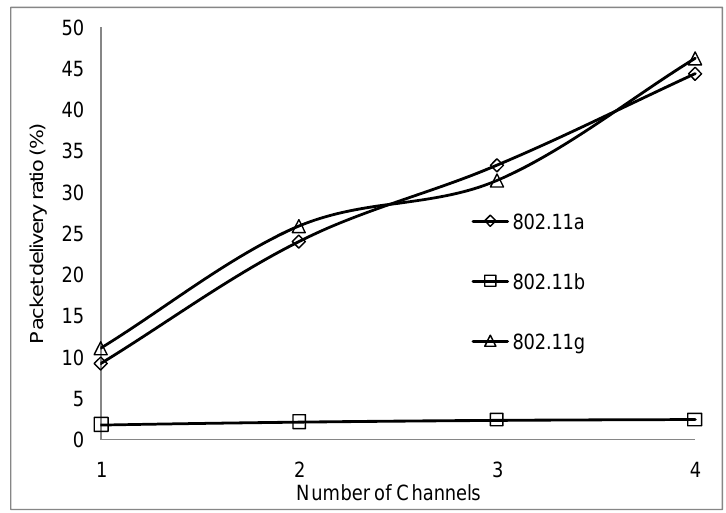
Figure 35. Delivery ratio at 100 m range and data rate of 54